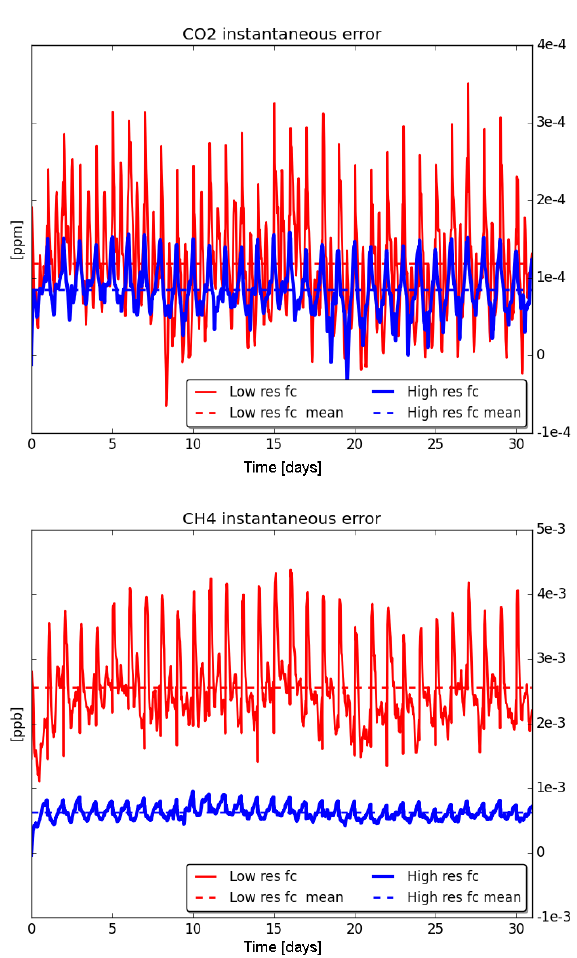
Figure 1. Instantaneous global mean mass conservation error for CO 2 (ppm) and CH 4 (ppb) from 1 to 31 March 2013. Low- and high-resolution experiments are depicted by red and blue lines re-